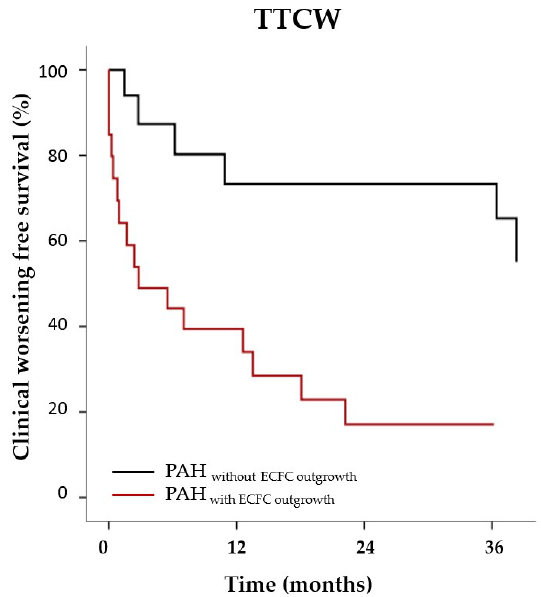
Figure 1. PAH patients with outgrowth of ECFC are more likely to experience early clinical worsening. Kaplan Meijer curves of PAH patients with outgrowth of ECFC (red, n = 21) without outgrowth of ECFC (grey, n = 12) over a period of 36 months ( x -axis). Cox-regression corrected for age; p = 0.032.